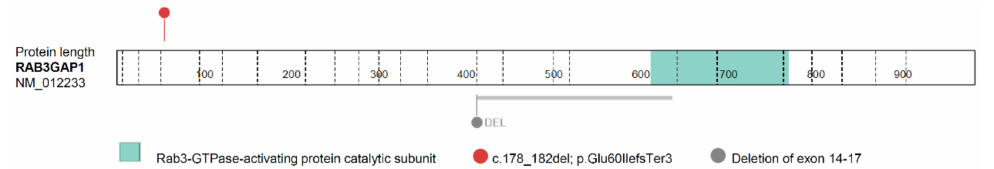
Figure 3. Schematic diagrams of RAB3GAP1 . Cyan-blue: Rab3-GTPase-activating protein catalytic subunit; Red label: c.178_182del, p. Glu60IlefsTer3 variant; Grey label: chromosome 2q21.3 deletion removing 4 of the 24 exons of RAB3GAP1 ; dotted line: boundary of